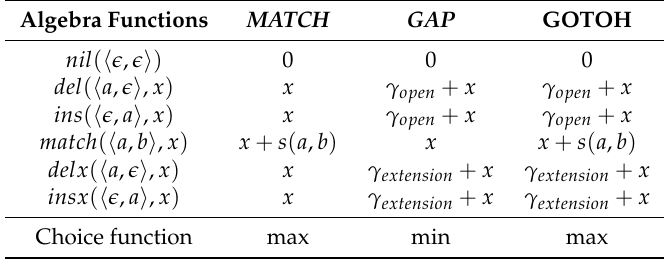
Table 1. Evaluation algebras MATCH and GAP. MATCH computes the score s ( a , b ) by aligning a with b , while GAP computes the penalties due to